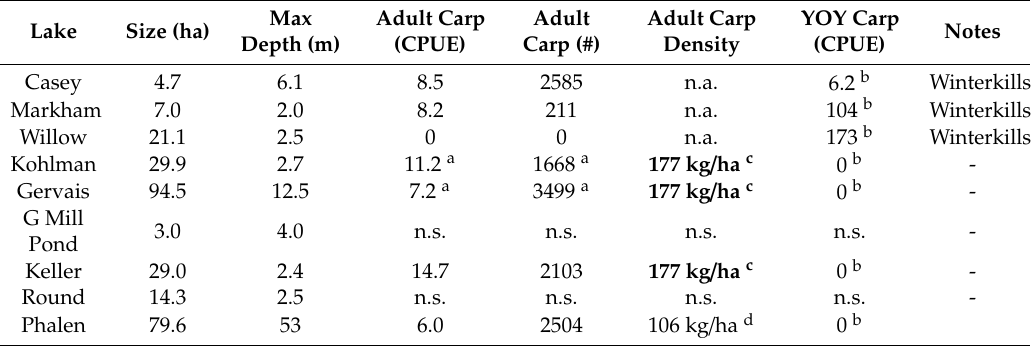
Table 1. Lakes and ponds in the Phalen Chain of Lakes and their carp as initially assessed in 2009–2010. CPUE (catch per unit e ff ort) for adults is the number of carp caught per hour by electrofishing, while CPUE for juveniles is the number of carp caught per trap-net (see text). Emboldened values are ecologically problematic (i.e., > 100 kg / ha). YOY = young-of–the-year carp.